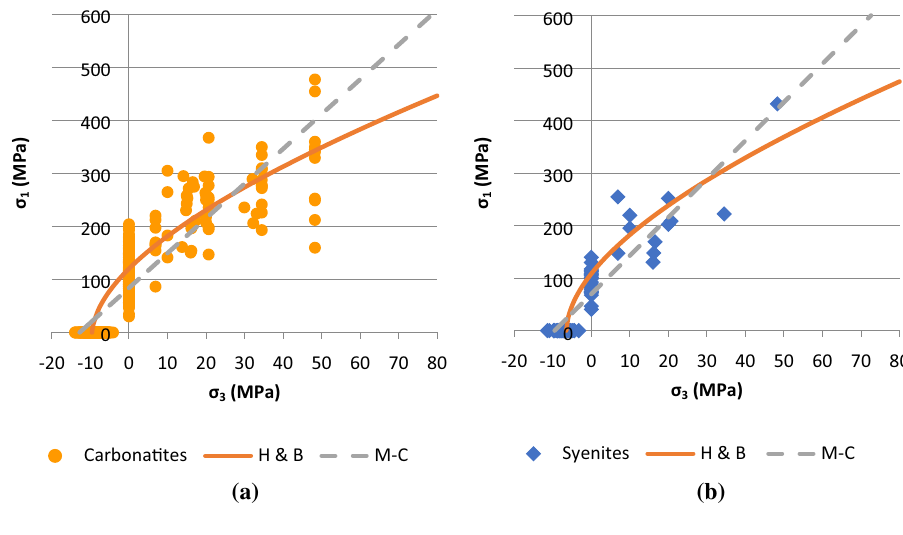
Fig. 6 Hoek–Brown and Mohr– Coulomb failure envelope for a Carbonatite and b Syenite